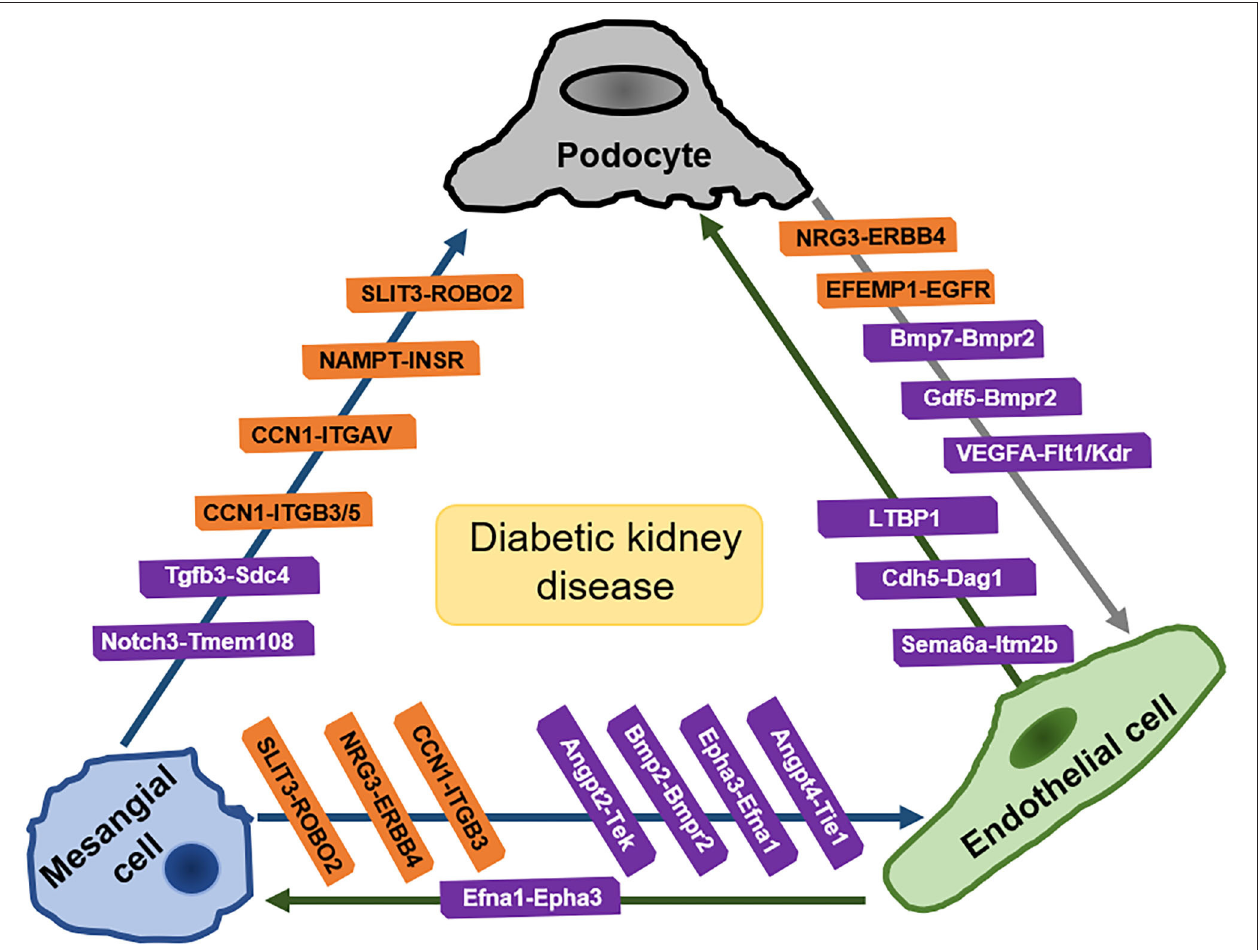
FIGURE 3 | Intraglomerular crosstalk based on ligand-receptor pair analysis of scRNA-seq. Pairs in orange frames come from the analysis of kidney of human with early diabetic nephropathy. Pairs in purple frames come from the analysis of kidney of diabetic mice. SLIT3, slit guidance ligand 3; ROBO2, roundabout guidance receptor 2; NAMPT, Nicotinamide phosphoribosyltransferase; INSR, insulin receptors; CCN1, cellular communication network factor1; ITGB3/5, integrin beta3/5; ITGAV, integrin subunit alpha-V; Tgfb3, Transforming growth factor 3; Sdc4, syndecan 4; Notch3, notch reporter 3; Tmem108, transmembrane protein 108; NRG3, neuregulin-3; ERBB4, Erb-B2 receptor tyrosine kinase 4; Bmp2, bone morphogenetic protein 2; Bmp7, bone morphogenetic protein 7; Bmpr2, bone morphogenetic protein receptor 2; Epha3, erythropoietin-producing hepatocellular carcinoma A3; VEGFA, vascular endothelial growth factor A; Flt1(VEGFR1, vascular endothelial growth factor receptor 1; Kdr (VEGFR2), vascular endothelial growth factor receptor 2; Angpt, angiopoietin; Tie (Tek): angiopoietin 1 receptor; Efnb2, ephrin B2; Efna1, ephrin A1; LTBP1, latent transforming growth factor (TGF)-beta binding protein-1; Cdh5, cadherin 5; Dag1, dystroglycan 1; Sema6a, semaphorin 6a; Itm2b, Integral membrane protein 2B; Cdf5, cycling dof factors 5; EFEMP1, Epidermal Growth Factor-containing Fibulin-like Extracellular Matrix Protein 1; EGFR, Epidermal Growth Factor Receptor. [Pairs in orange are summarized from Mitu et al. (93) and pairs in purple are summarized from Fu et al.